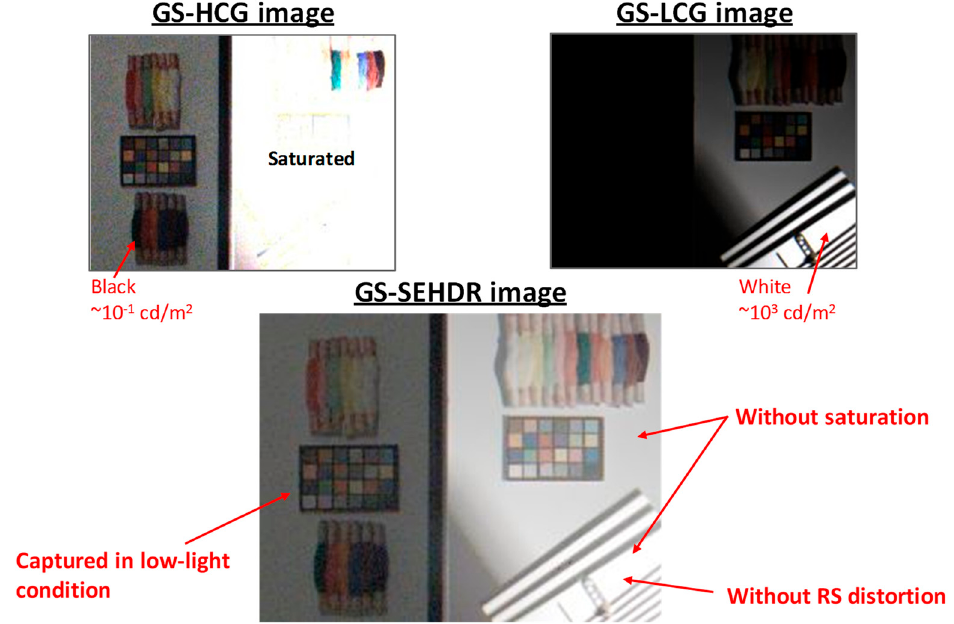
Figure 14. Sample images captured in the global shutter (GS) single exposure high dynamic range (SEHDR) mode with 15 frames per second (fps).